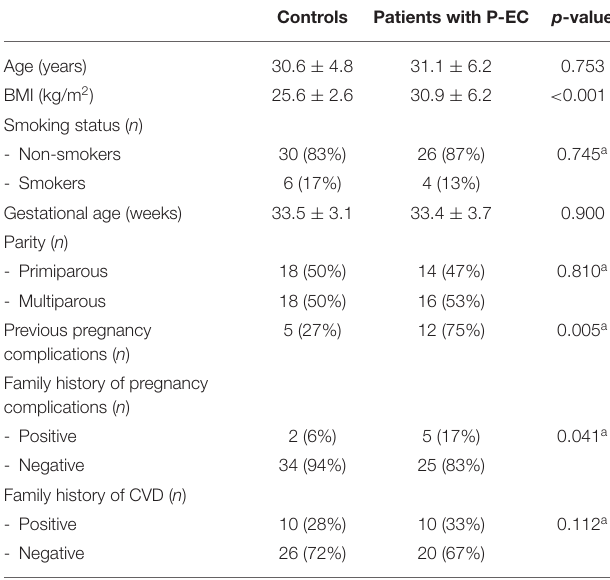
TABLE 1 | General characteristics of patients with P-EC ( n = 30) and controls ( n =